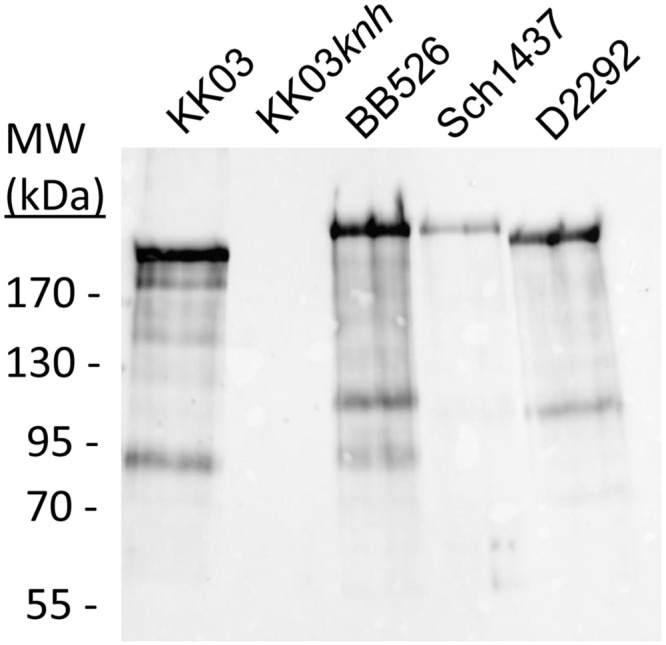
K. negevensis produces a Knh homolog.Outer membrane fractions were isolated from strains KK03, KK03knh, BB526, Sch1437, and D2292, treated with formic acid, and separated using SDS-PAGE. Following transfer to nitrocellulose, samples were probed with GP97, an antiserum targeting the YadA-like head domains of K. kingae Knh. All three K. negevensis strains have a high molecular weight reactive band, indicating production of the Knh homolog, similar to the positive control K. kingae KK03.